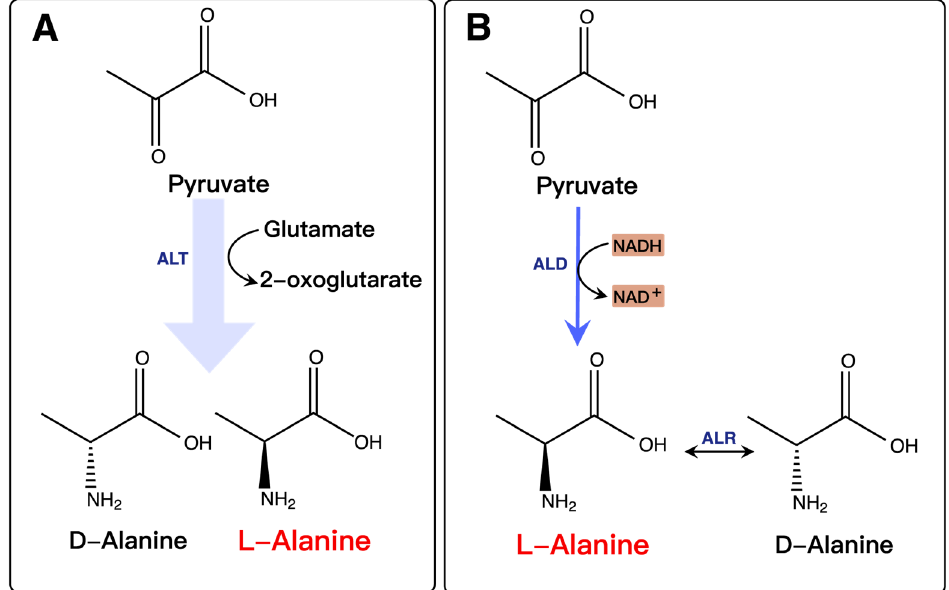
Figure 5. L-alanine synthesis by ( A ) alanine transaminase (ALT) and ( B ) L-alanine dehydrogenase (ALD).